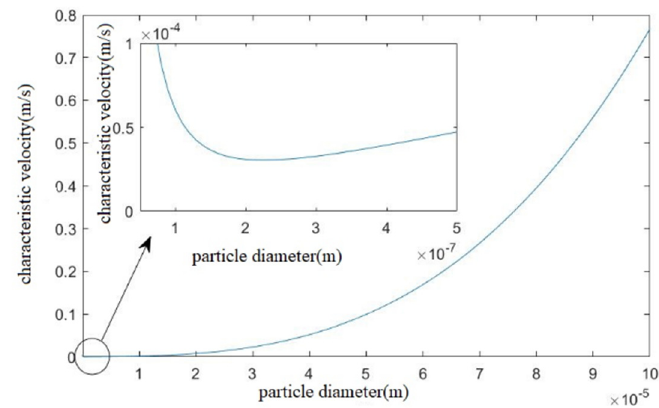
Figure 8. Variation of the reverse velocities with the diameters of the solid particles.